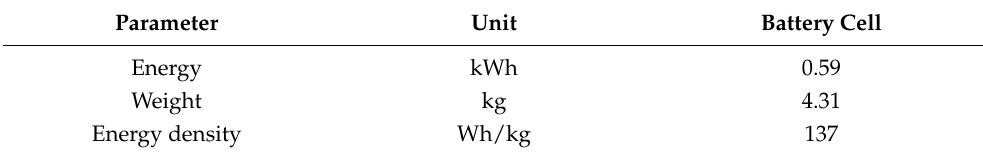
Table 4. Battery cell parameters of BYD E6.